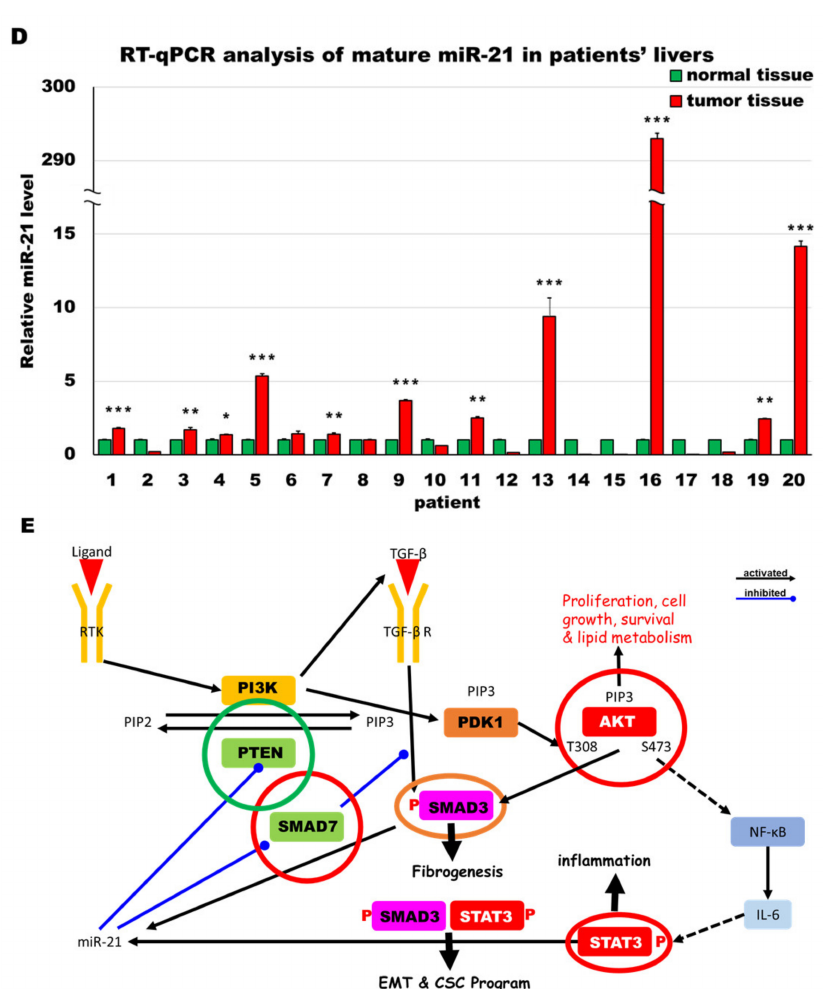
Figure 8. MiR-21 expression shows a direct correlation with activation of PI3K, TGF- β and STAT3 (PTS) signaling network proteins in LmiR21 zebrafish and human nonviral hepatocellular carcinomas (HCC). ( A ) Expression patterns of Ptenb, p-Akt, Smad7, p-Smad3 and p-Stat3 in 10 mpf LmiR21 ± Dox liver samples after immunohistochemical (IHC) staining. Scale bar: 50 µ m. Positive signal areas per field were quantified. ( B ) Western blot images (left) and quantitative data (right) of PTS signaling regulatory protein in 10 mpf LmiR21 ± Dox liver. ( C ) Human nonviral HCC samples ( n = 20) were subjected to IHC of PTEN, p-AKT, SMAD7, p-SMAD3 and p-STAT3 expression. Scale bar: 50 µ m. ( D ) miR-21 expression profiles in the surrounding normal and liver cancer tissues from nonviral HCC patients ( n = 20) were analyzed by RT-qPCR. Positive correlation of miR-21 with PTS signaling regulatory genes in 60% of the nonviral HCC samples were observed. ( E ) Proposed mechanism by which miR-21 links the NAHCC development. MiR-21 mediates a newly discovered PI3K/Akt, TGF- β /Smad3 and Stat3 (PTS) signaling loop and feed forward loop involving Smad3/Stat3 dependent on miR-21 expression. (Abbreviations: → : activated, – • : inhibited) Statistically significant differences from LmiR21 − Dox were denoted by * ( p < 0.05), ** ( p < 0.01) and *** ( p < 0.001) for panels A, B and